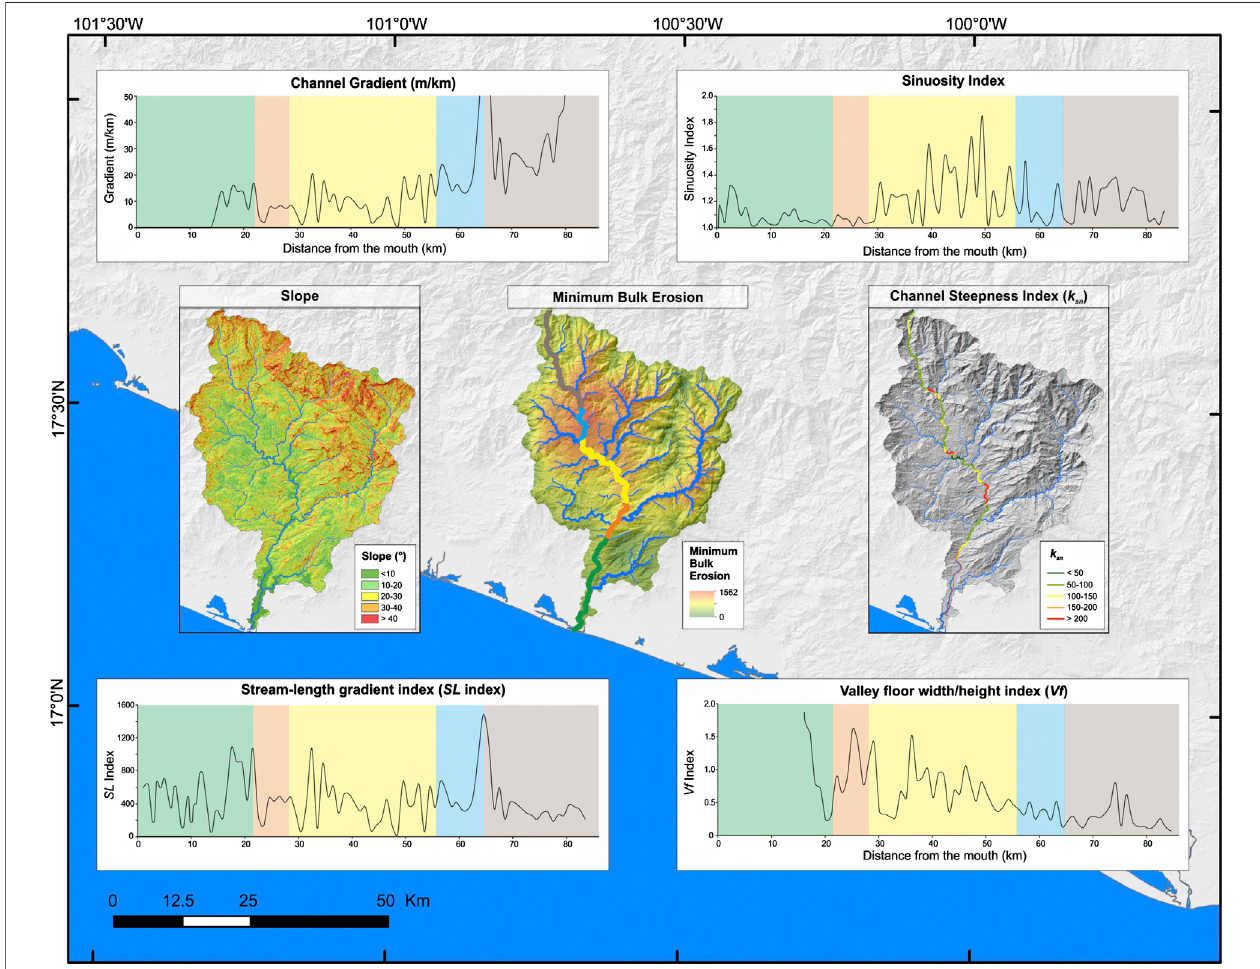
FIGURE 4 | Morphometry and geomorphometric indices calculated for the Tecpan drainage basin and within de fi ned segments along the Tecpan River.